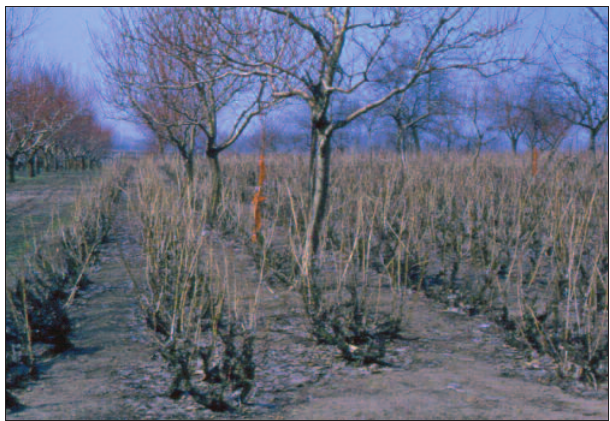
Fig. 8. Old vineyard for clonal